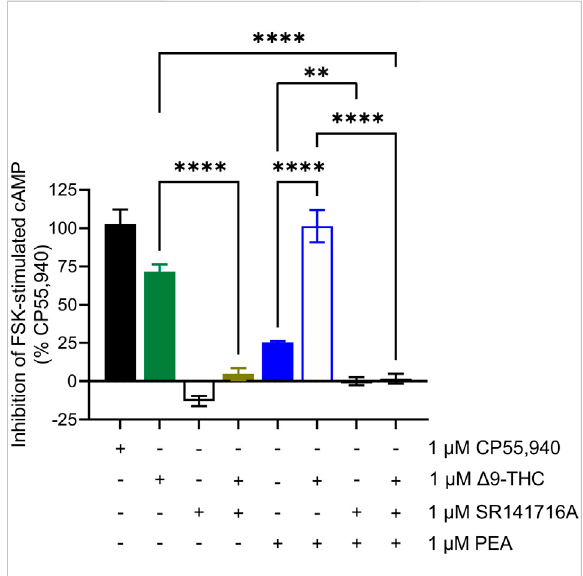
FIGURE 5 hCB1R-dependent inhibition of forskolin-stimulated cAMP accumulation. Compound activity was quanti fi ed for inhibition of 10 μ M forskolin-stimulated cAMP accumulation in CHO cells stably expressing hCB1R and treated with compounds as indicated for 90 min according to the standard operating procedures of the HitHunter assay. Data were analyzed in GraphPad(v.9). n =6independentexperimentswereperformedin triplicate. Data are expressed as mean ± SEM. ** p < 0.01, **** p < 0.0001 as determined by one-way ANOVA followed by Tukey ’ s post hoc test for multiple